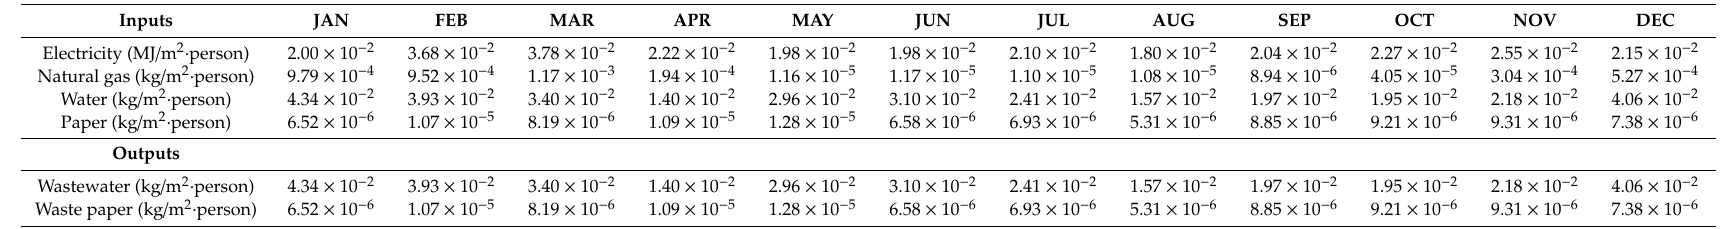
Table 2. Life cycle inventory of the Civil Engineering